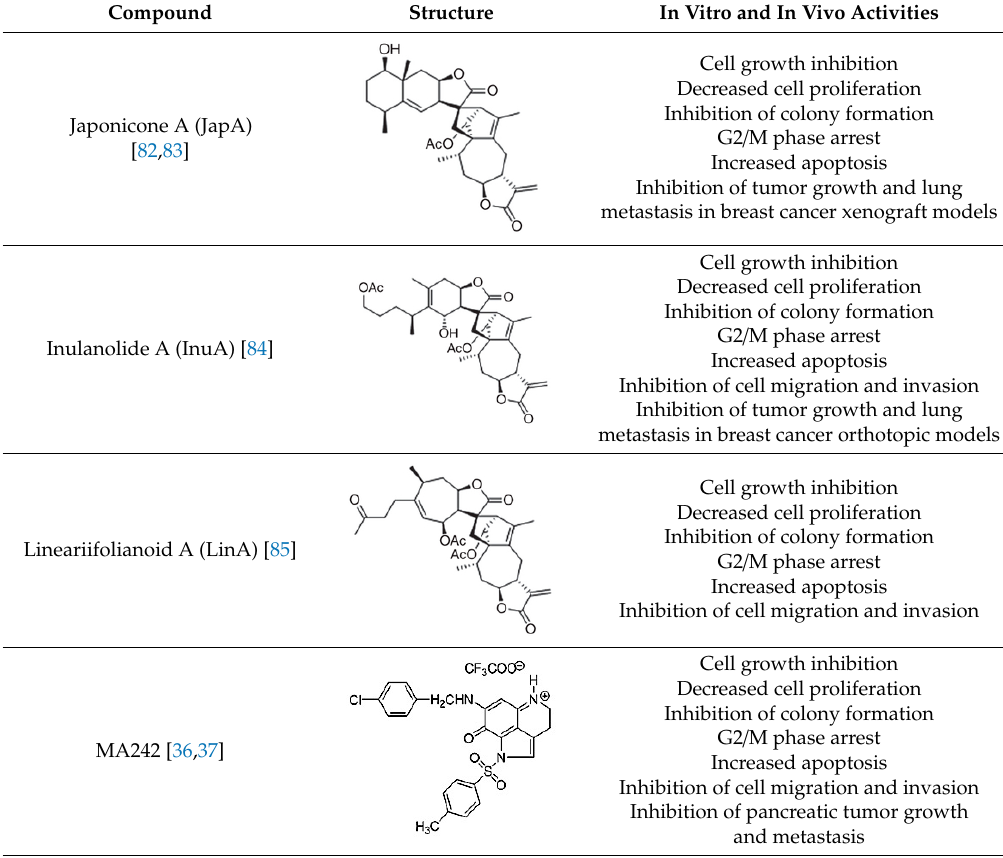
Table 1. Selected NFAT1-MDM2 dual inhibitors and in vitro and in vivo anticancer activities. Compound